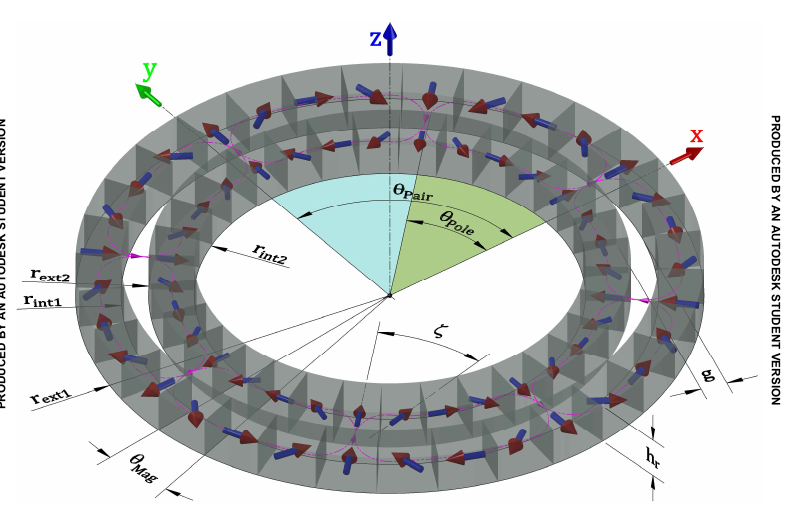
Figure 20. Radial Halbach array-based magnetic coupling with arched magnets, poles-pair p = 4, and Halbach stage H s =